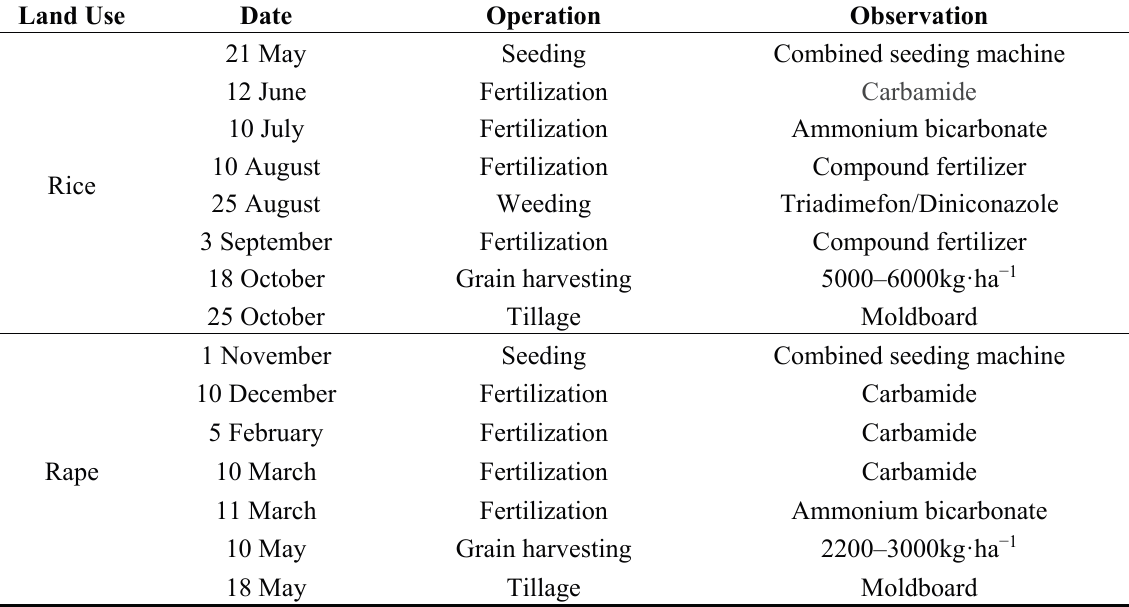
Table 2. Schedules of annual cultivation and agricultural practices in the Wucun watershed. Land